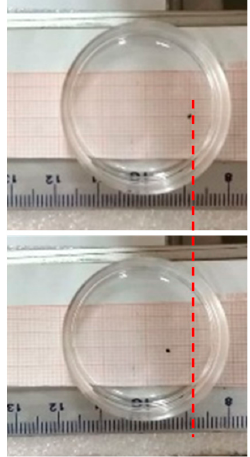
Figure 4. Ferrofluid microdroplet being pushed in oleic acid.